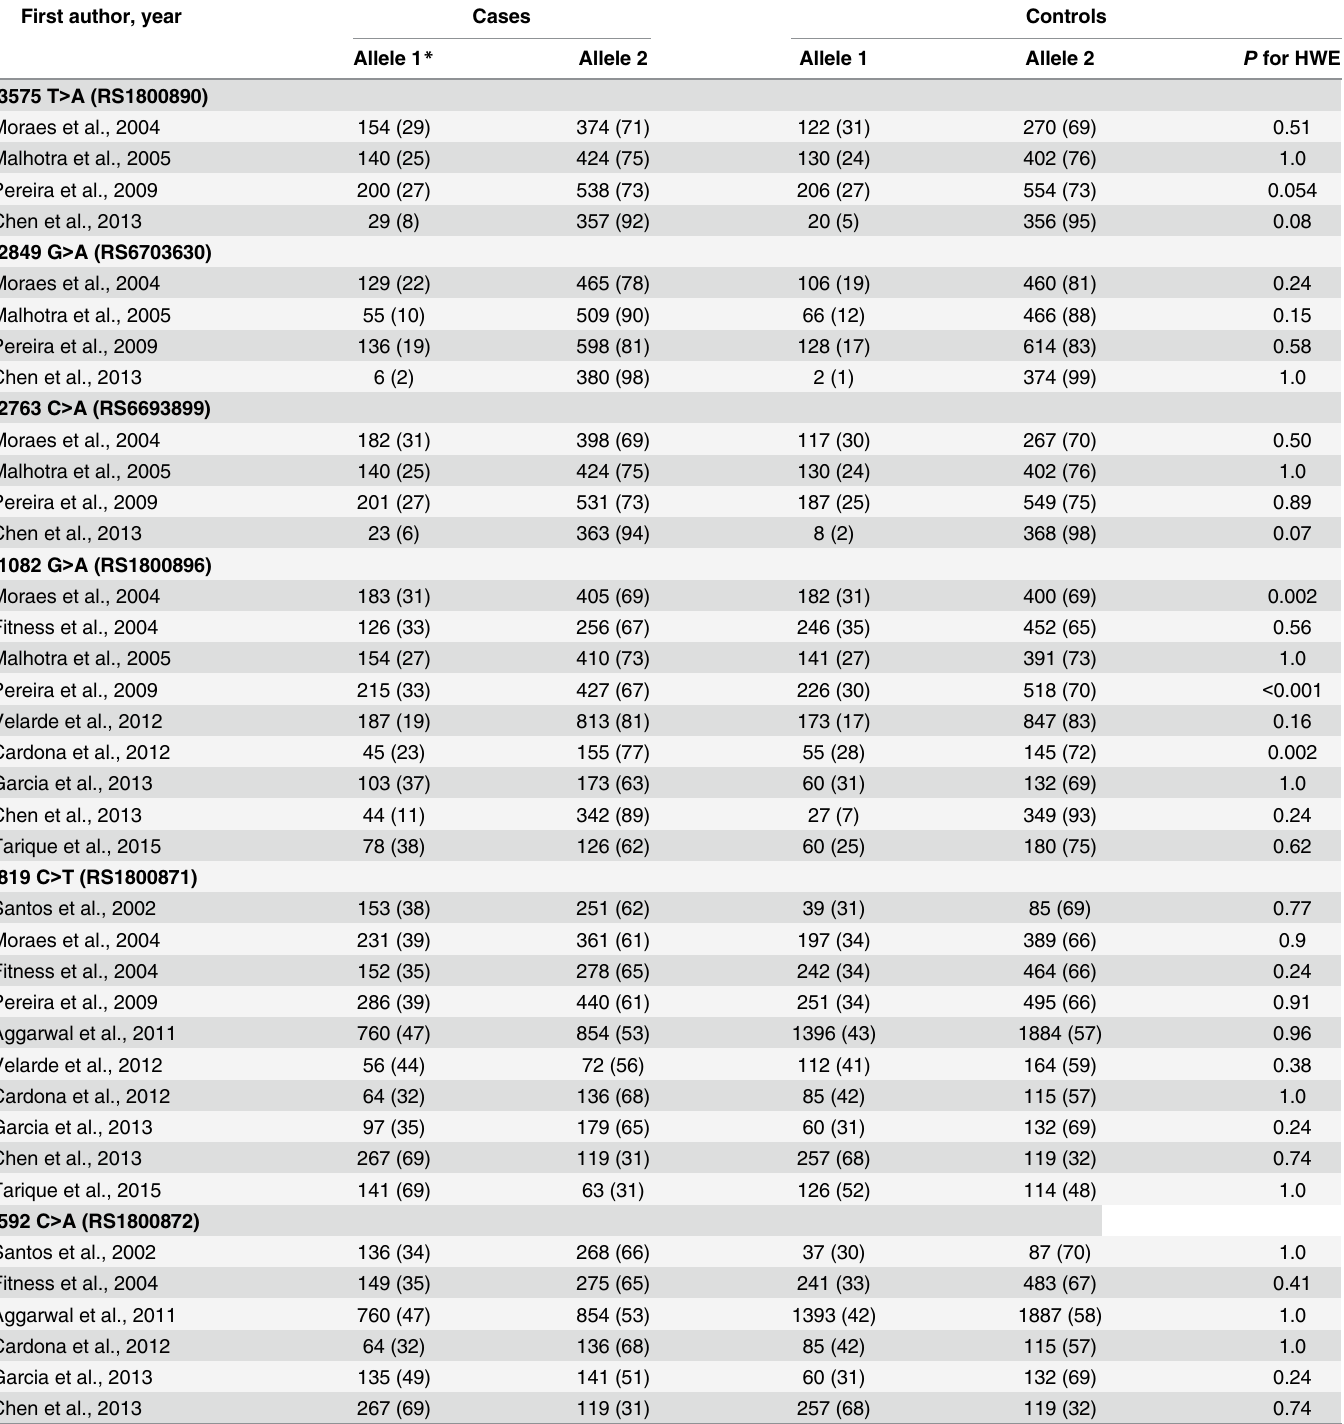
Table 3. Summary of extracted data from the papers selected for the